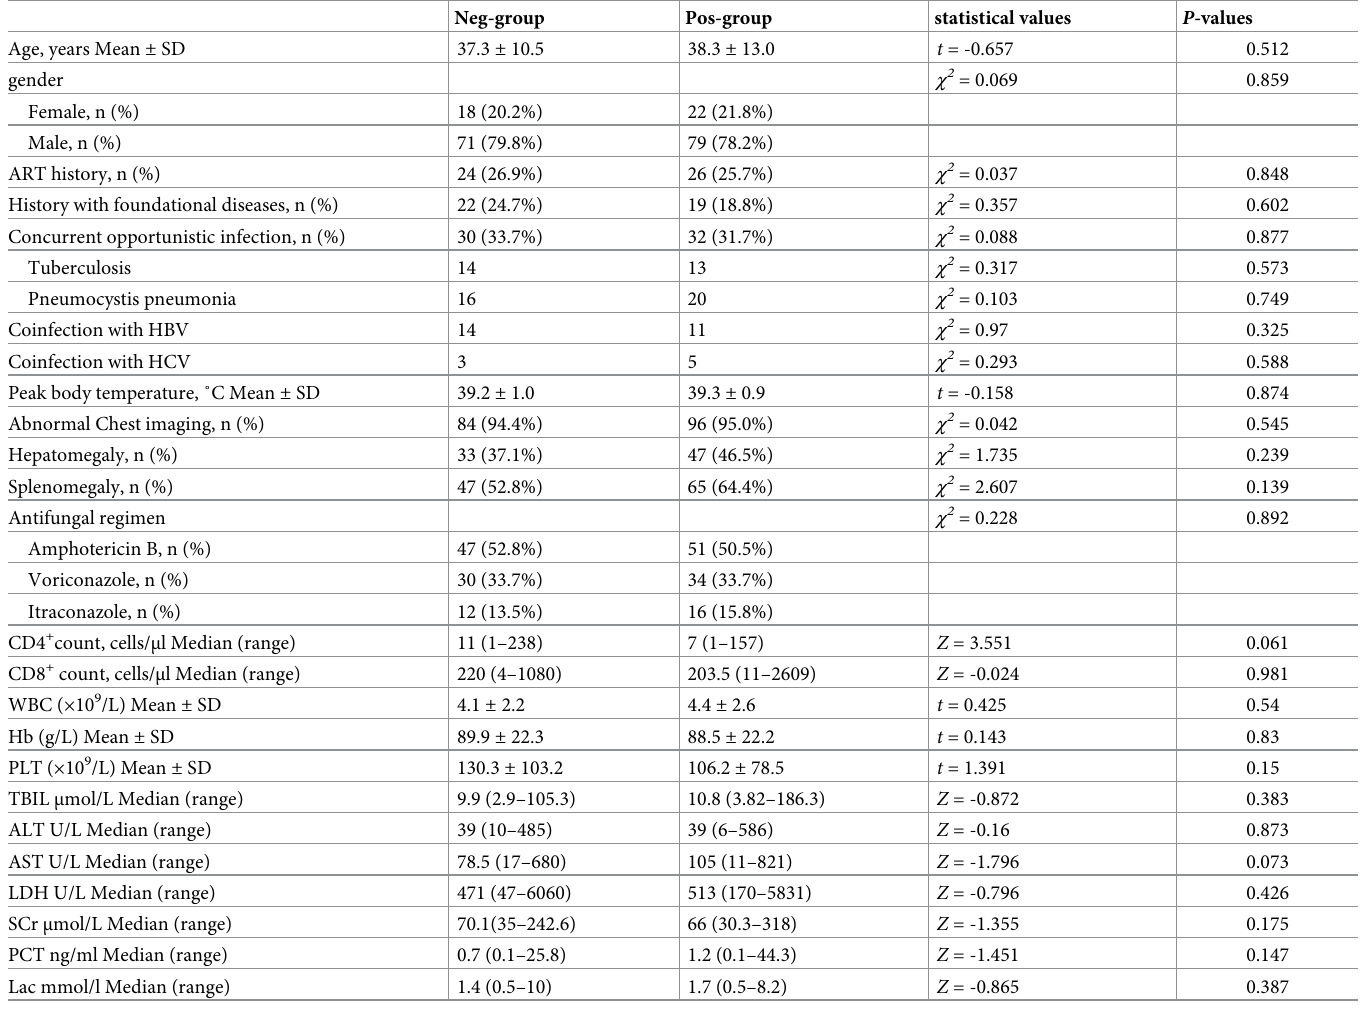
Table 1. Demographic and baseline clinical characteristics of 190 patients with AIDS and